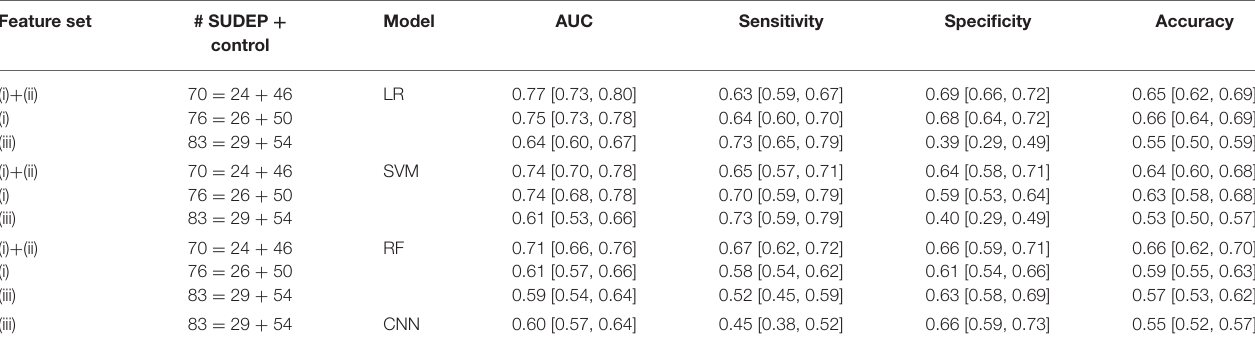
TABLE 2 | Comparison of model performance [median interquartile range (IQR)] in five-fold cross-validation. Feature set # SUDEP + Model AUC Sensitivity Specificity control